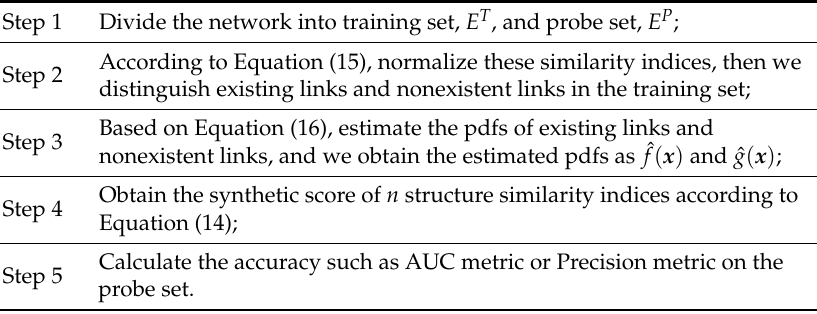
Table 1. The steps of theoretical limit fusion (TLF)